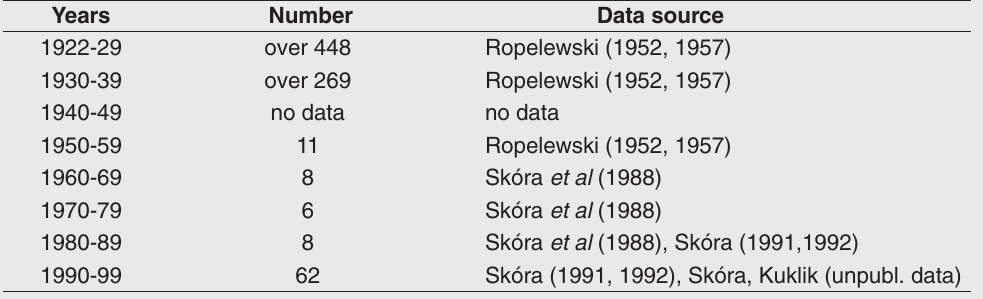
Table 4. Historical and contemporary data on the numbers of harbour porpoise in Polish Baltic waters (data prior to 1940 comes from the Gulf of Gdansk, the Polish fleet operating area at that time). For the years 1922-1939 data on bycatches are from fishery statistics; for 1940-1989 occasional data on bycatches, sightings and strandings; for 1990-99 data on bycatches, sightings and strandings collected as a result of information